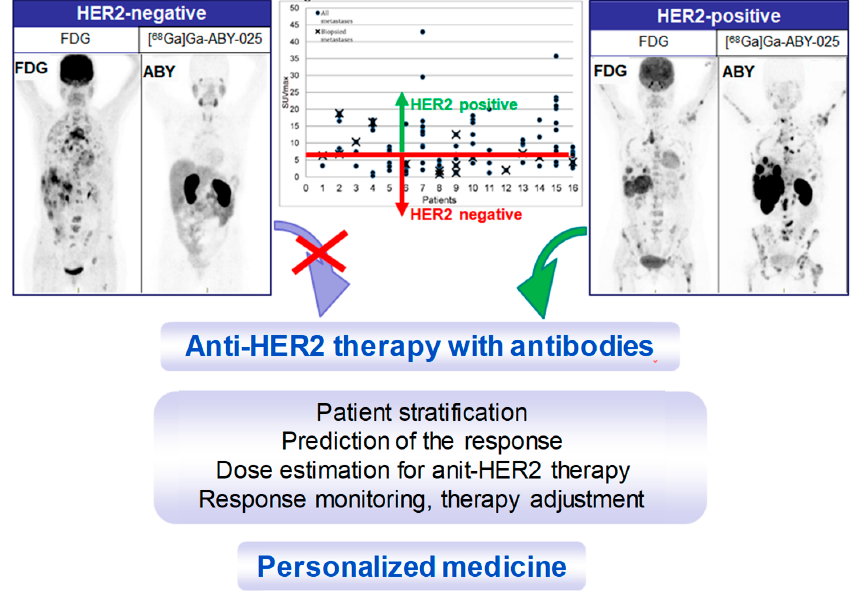
Figure 13. Maximum intensity projection PET images from two studied patients with wide-spread metastatic breast cancer. Left panel: HER2-negative. Right panel: HER2-positive. All images are normalized to SUV 10. Darker colors indicate higher uptake. The graph presents the range of [ 68 Ga]Ga-ABY-025 SUV max in all nodular metastases (black dots) identified using [ 18 F]FDG-PET/CT in all 16 patients undergoing [ 68 Ga]Ga-ABY-025 PET/CT at 2 h after injection of tracer with high peptide content. Crosses symbolize biopsied metastases. The red line indicates a proposed threshold at SUV max = 6 for discriminating HER2-positive and HER2-negative metastases. Adopted from [5].